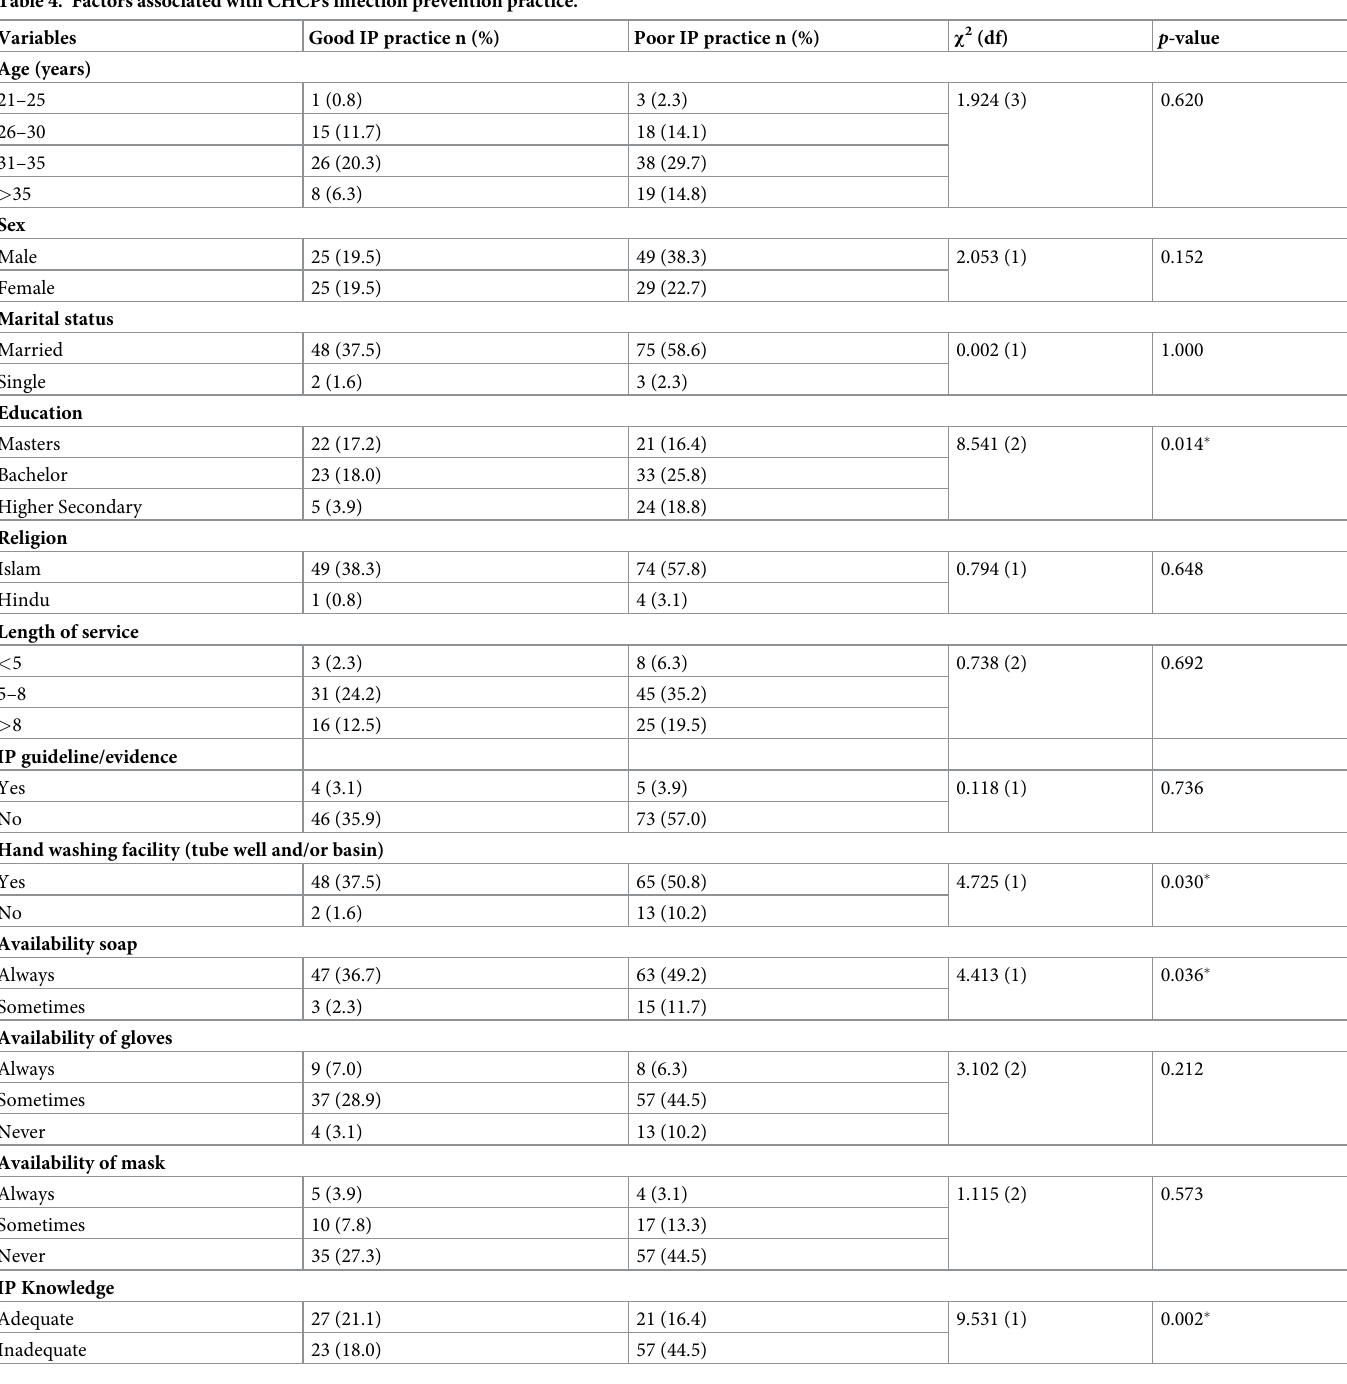
Table 4. Factors associated with CHCPs infection prevention